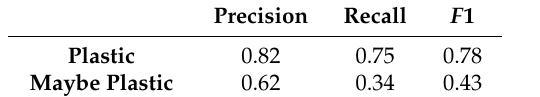
Figure 9. Relationship between the spatial resolution (cm/pixel) and the area covered by an image gathered by the DJI Mavic ProCamera (grid mission with an 80 % overlap).